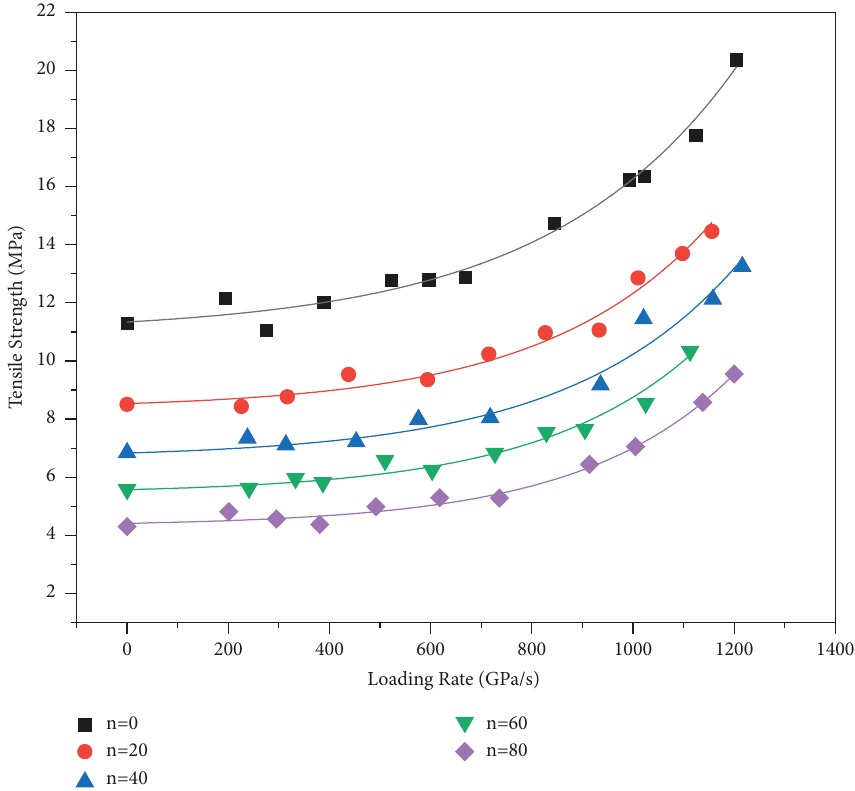
Figure 6: Change law of σ t of red sandstone samples versus the loading